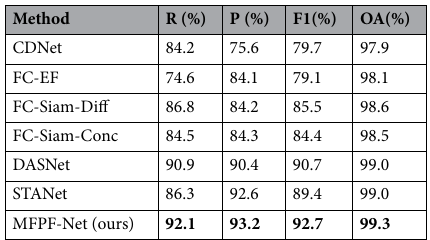
Table 4. Comparison of WHU-CD dataset results (the best performance is emphasized in bold).